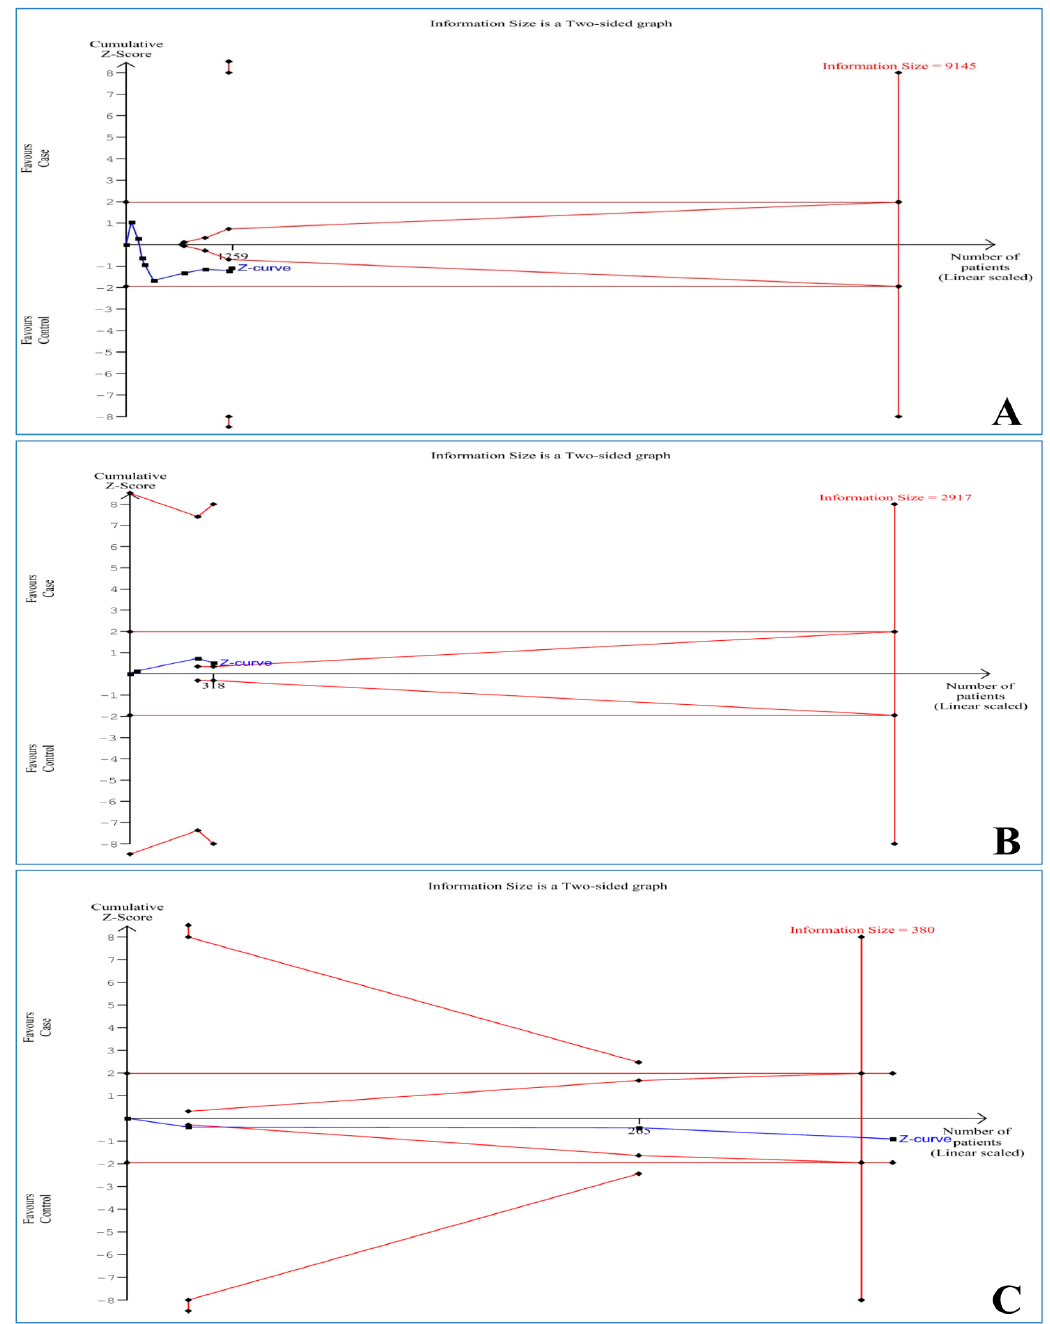
Figure 2. Trial sequential analysis for the association between polymorphisms and dental peri-implant disease risk based on heterozygous model: ( A ) TNF- α ( − 308 G > A) , ( B ) IL-10 ( − 1082 A > G) , and ( C ) IL-10 ( − 819 C > T).